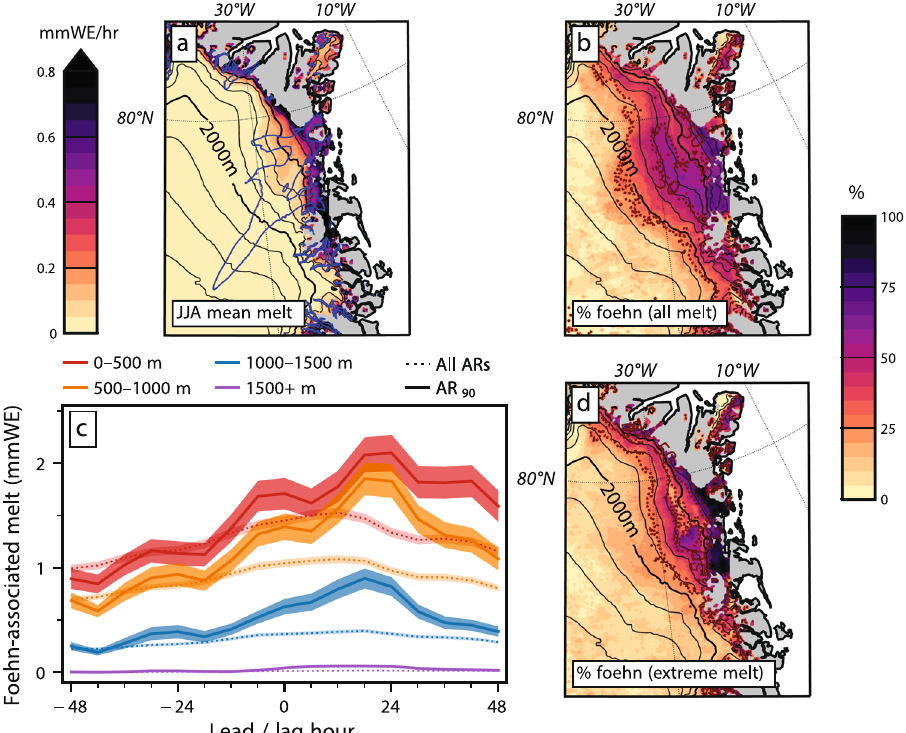
Fig. 5 | In fl uence of atmospheric rivers (ARs) and foehn conditions on north- east (NE) Greenland melt. a Climatological mean hourly melt in NE Greenland duringsummer(JJA). b Percentageofmeltcoincidentwithfoehnconditionsduring the 0 – 48h period after 90th percentile ARs (AR 90 ) in northwest (NW) Greenland. c Temporal evolution of foehn-driven melt in northeast (NE) Greenland in 500m elevation bands during the − 48 to +48h period surrounding NW Greenland ARs.